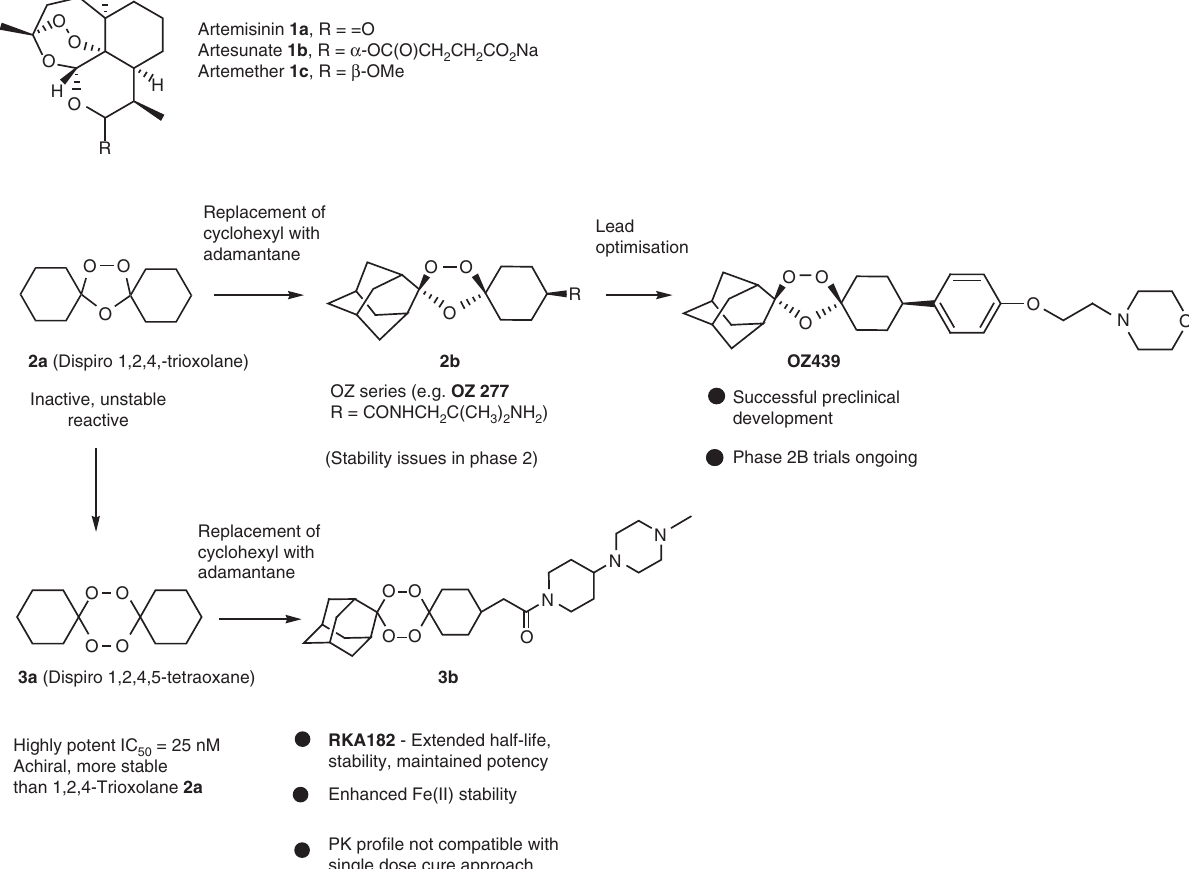
(Table 1). Efficacy of E209 against the human malaria parasite was tested in the immune-deficient NOD-SCID IL-2R_null mouse engrafted with human erythrocytes and infected with the P. falciparum strain 3D7 0087/N9 (ref. 25). Complete parasite clearance was achievable with a single oral dose of E209 (30 mg kg (cid:3) 1 ) with a calculated ED 90 of 11.6 mg kg (cid:3) 1 and an AUC ED 90 of 1.2 m g h ml (cid:3) 1 (Fig. 4). This compares with an ED 90 of 10 mg kg (cid:3) 1 for artesunate following four consecutive daily doses 26 . The maximum rate of parasite killing by E209 was achieved with blood exposure between 5 and 10 m g h ml (cid:3) 1